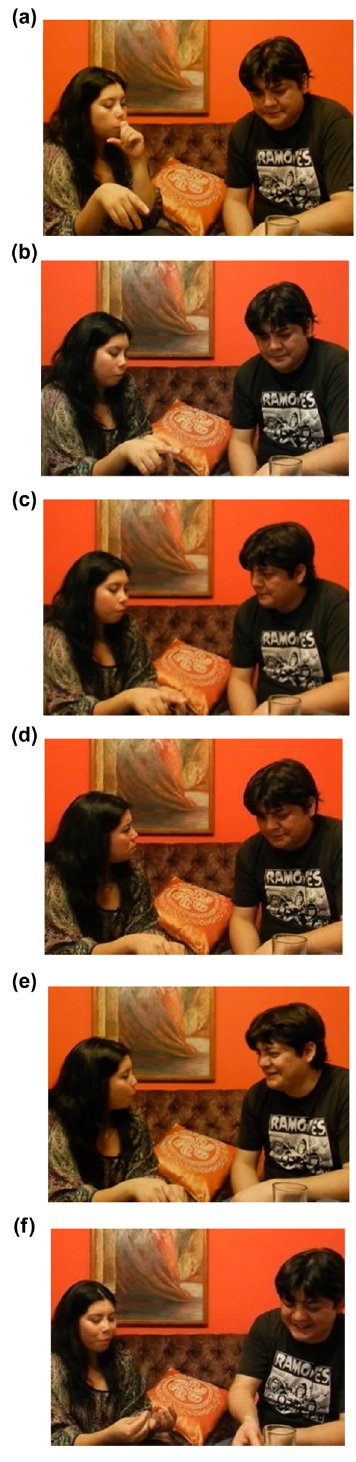
Figure 1: Screenshots ( a, b, c, d, e and f ) illustrating the embodied behaviour at lines 15, 16, 18, 22, 23, and 24,